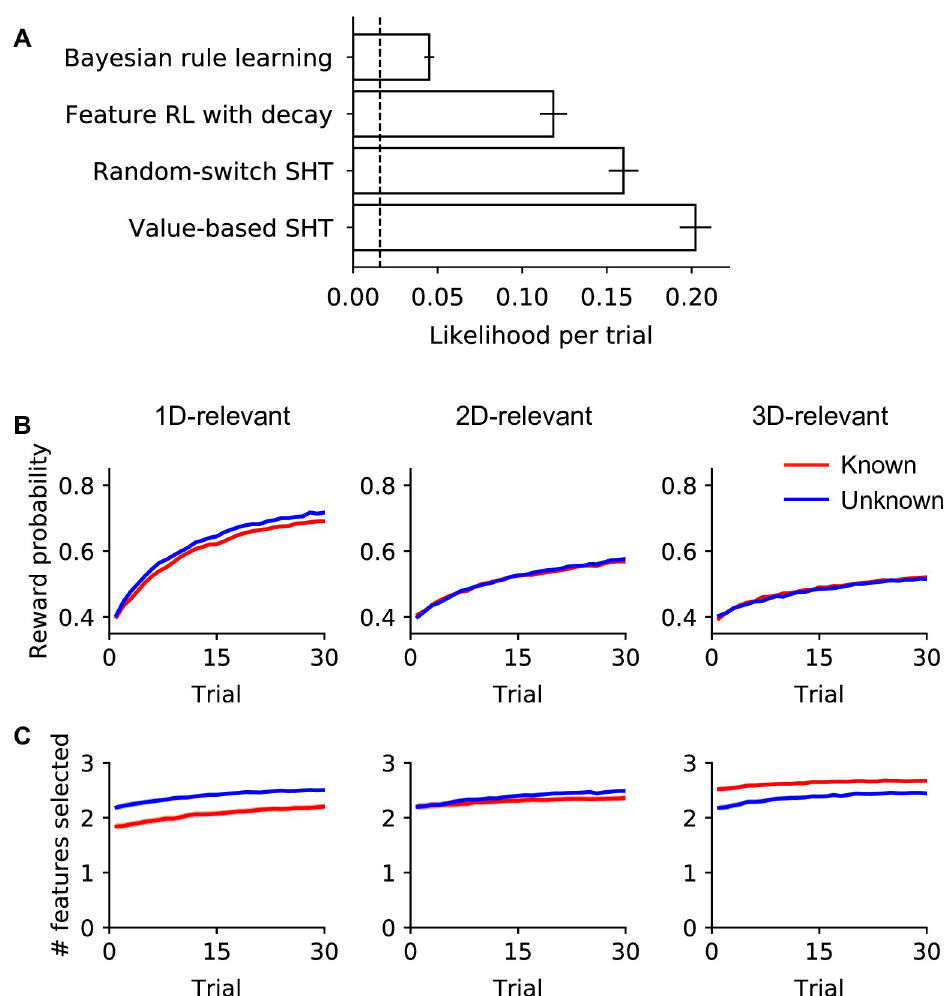
Fig 4. Model comparison supports both reinforcement learning (RL) and serial hypothesis testing (SHT) strategies. (A) Geometric average likelihood per trial for each model (i.e., average total log likelihood divided by number of trials and exponentiated). Higher values indicate better model fits. Dashed lines indicate chance. Error bars represent ± 1 s.e.m. across participants. (B, C) Simulation of the best-fitting value-based SHT model. The same learning curves as in Fig 2 but for model